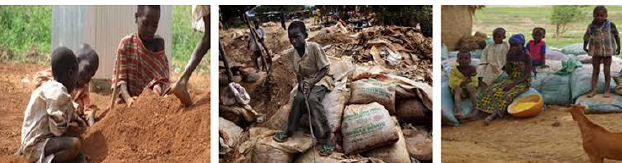
Figure 3: Children engaged in the processing of gold (Source: hrw.org)